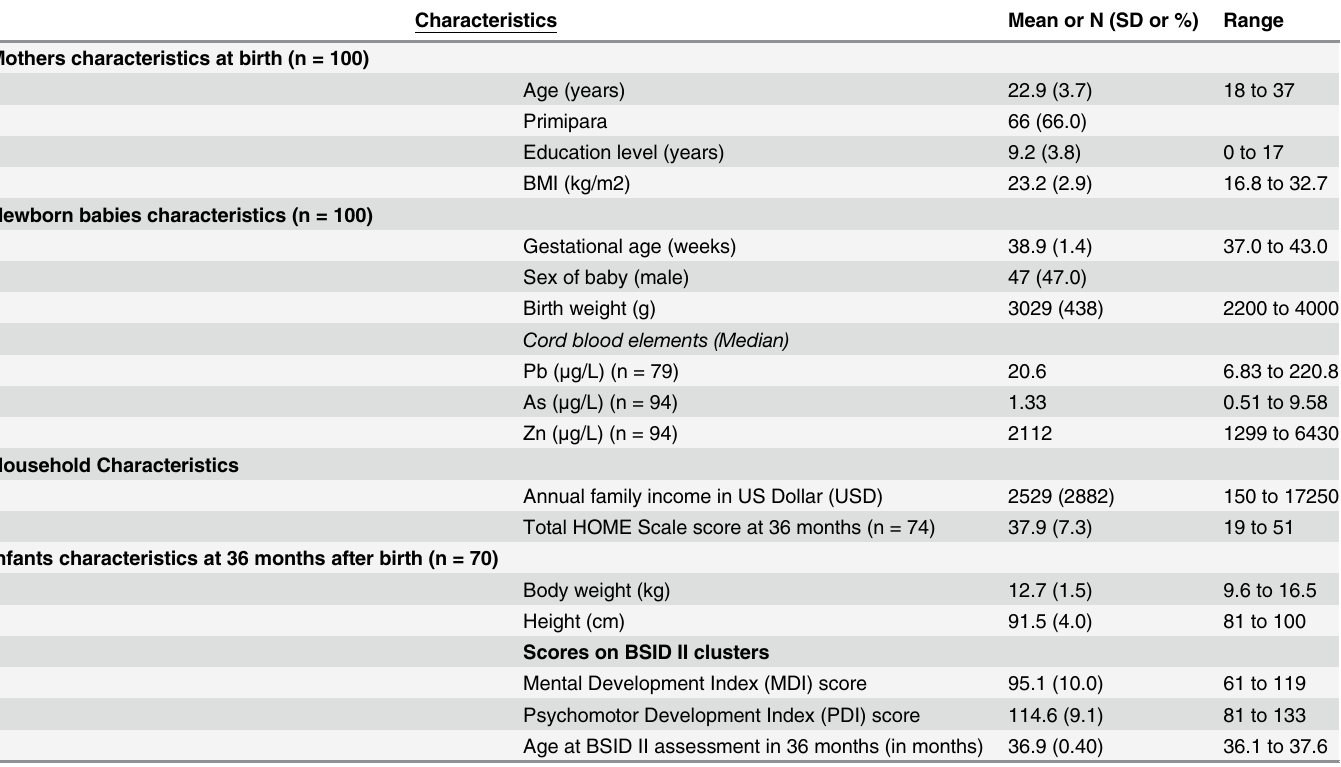
Table 1. Characteristics of the mothers and infants who participated in the